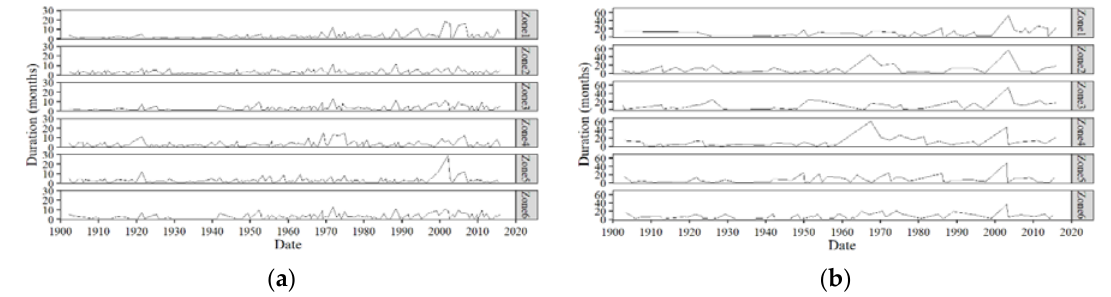
Figure 11. ( a ) 3-month and ( b ) 12-month durations of Figure 11. ( a ) 3 ‐ month and ( b ) 12 ‐ month durations of droughts.